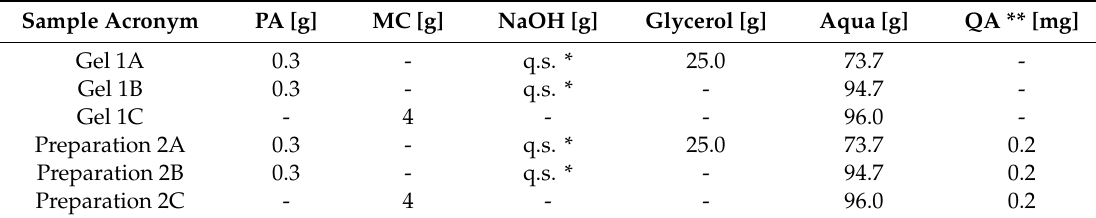
Table 1. Preparation of Polymeric Gels.